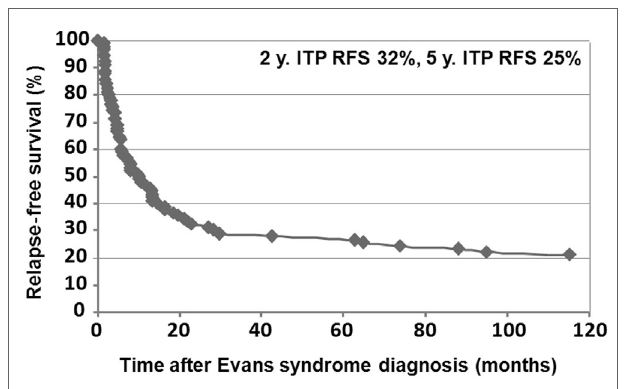
FigUre 4 | Kaplan–Meier iTP relapse-free survival in 90 children